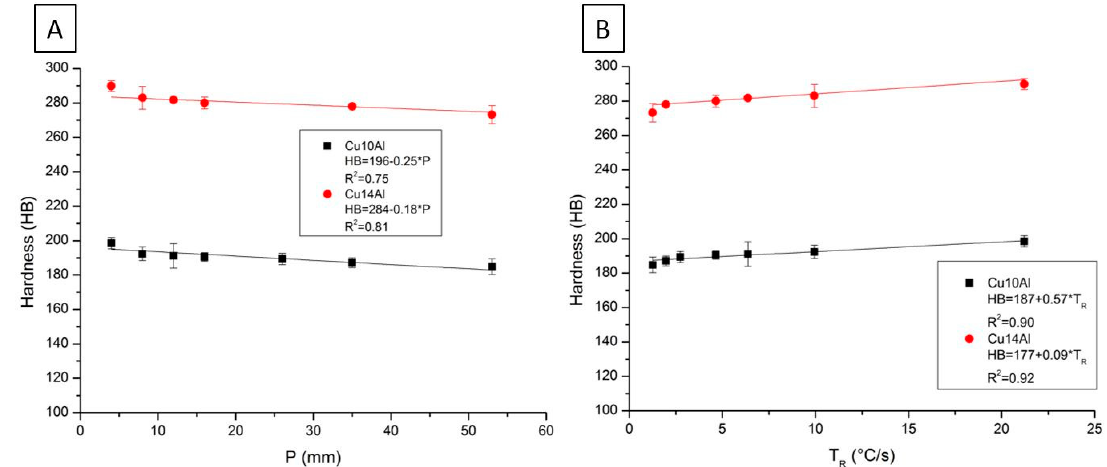
Figure 5. ( A ) Correlation between hardness (HB) and distance from heat extraction surface (P); and ( B ) correlation between HB and cooling rate (T R ). The error bars represent the standard deviation of the measurements obtained.